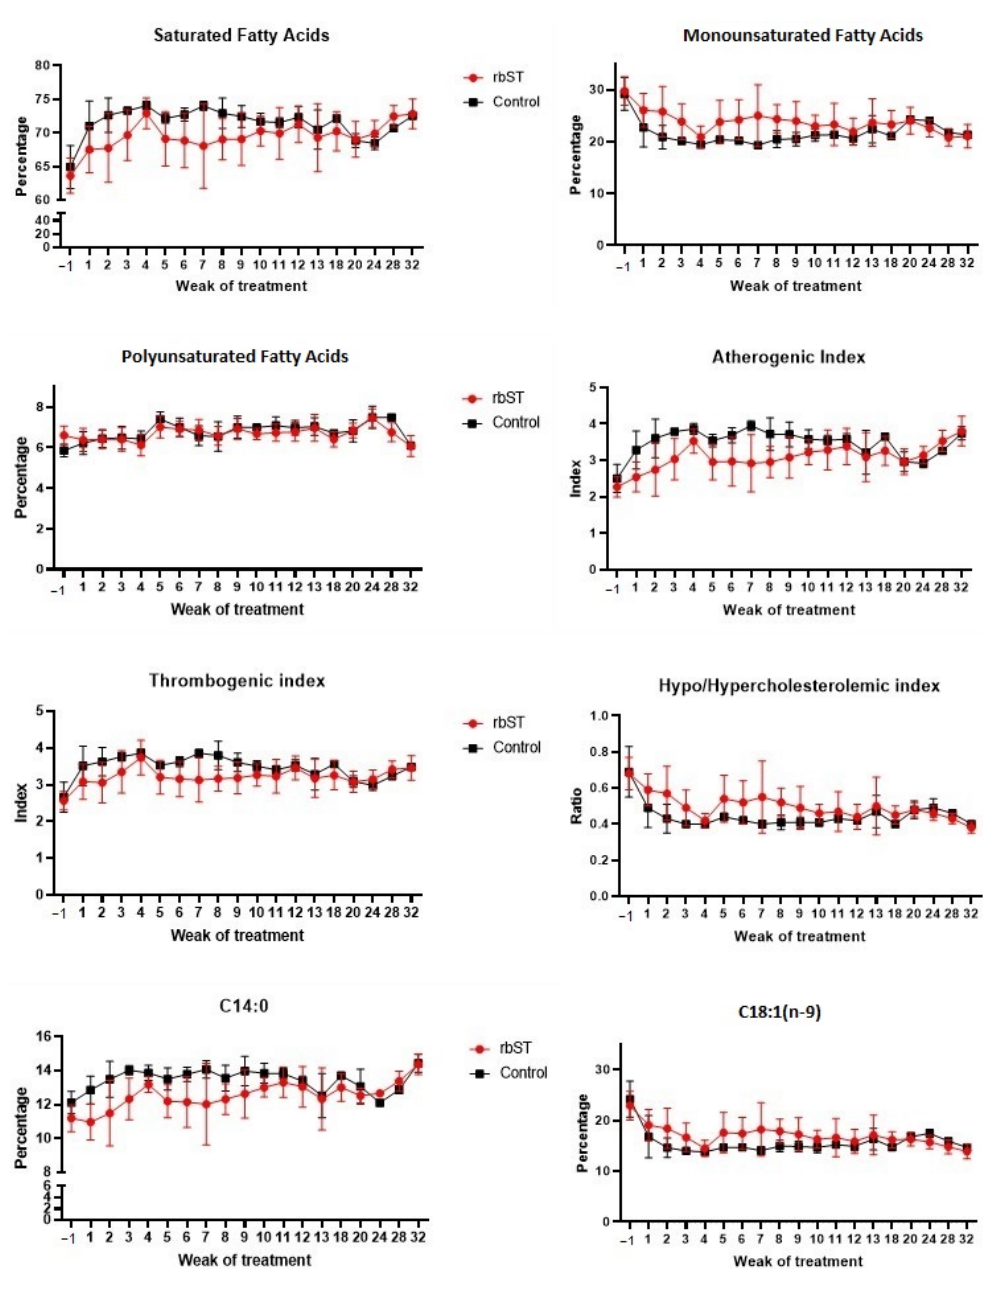
Figure 1. Evolution of various fatty acids (% w / w of total fatty acids) and quality indexes in milk from control and recombinant bovine somatotropin (rdST)cows presented over the course of 32 weeks of study (12 rbST biweekly doses).